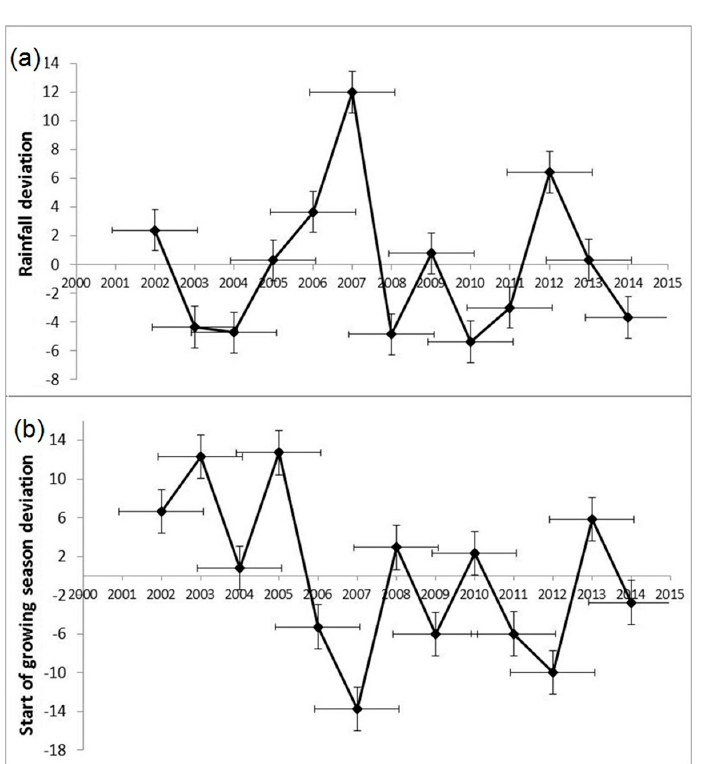
Figure 12. Yearly deviation of July-September mean rainfall (5 meteorological stations) from the 13 year (2002–2014) mean ( a ); and yearly deviation of start of growing season date for 100 randomly selected polygons in the study area ( b ).